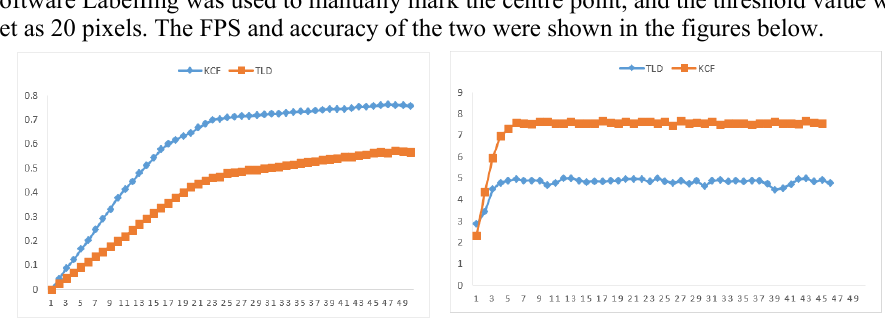
Fig. 2. Algorithm Accuracy Line Graph Figure. Fig. 3. FPS Line